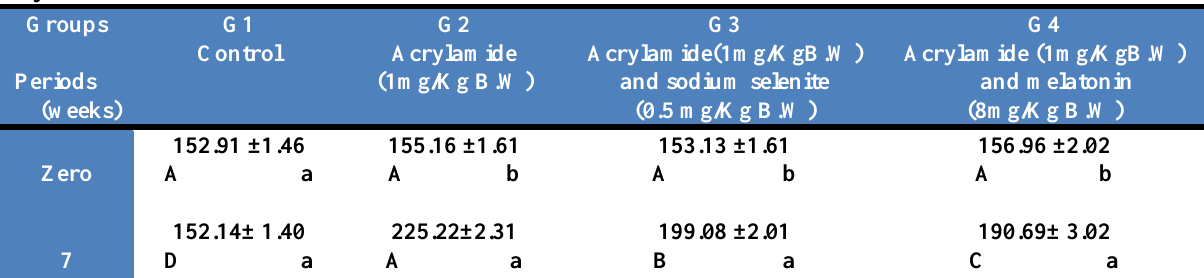
Values are expressed as mean ±SE, n=5. Different small letters represent significant difference within group (P<0.05) vs. zero time. Different capital letters represent a significant difference between groups (P<0.05) vs. control. Table, 3: Effect of sodium selenite and melatonin on serum triacylglycerol (TAG) concentration (mg/dl) in acrylamide treated rats.